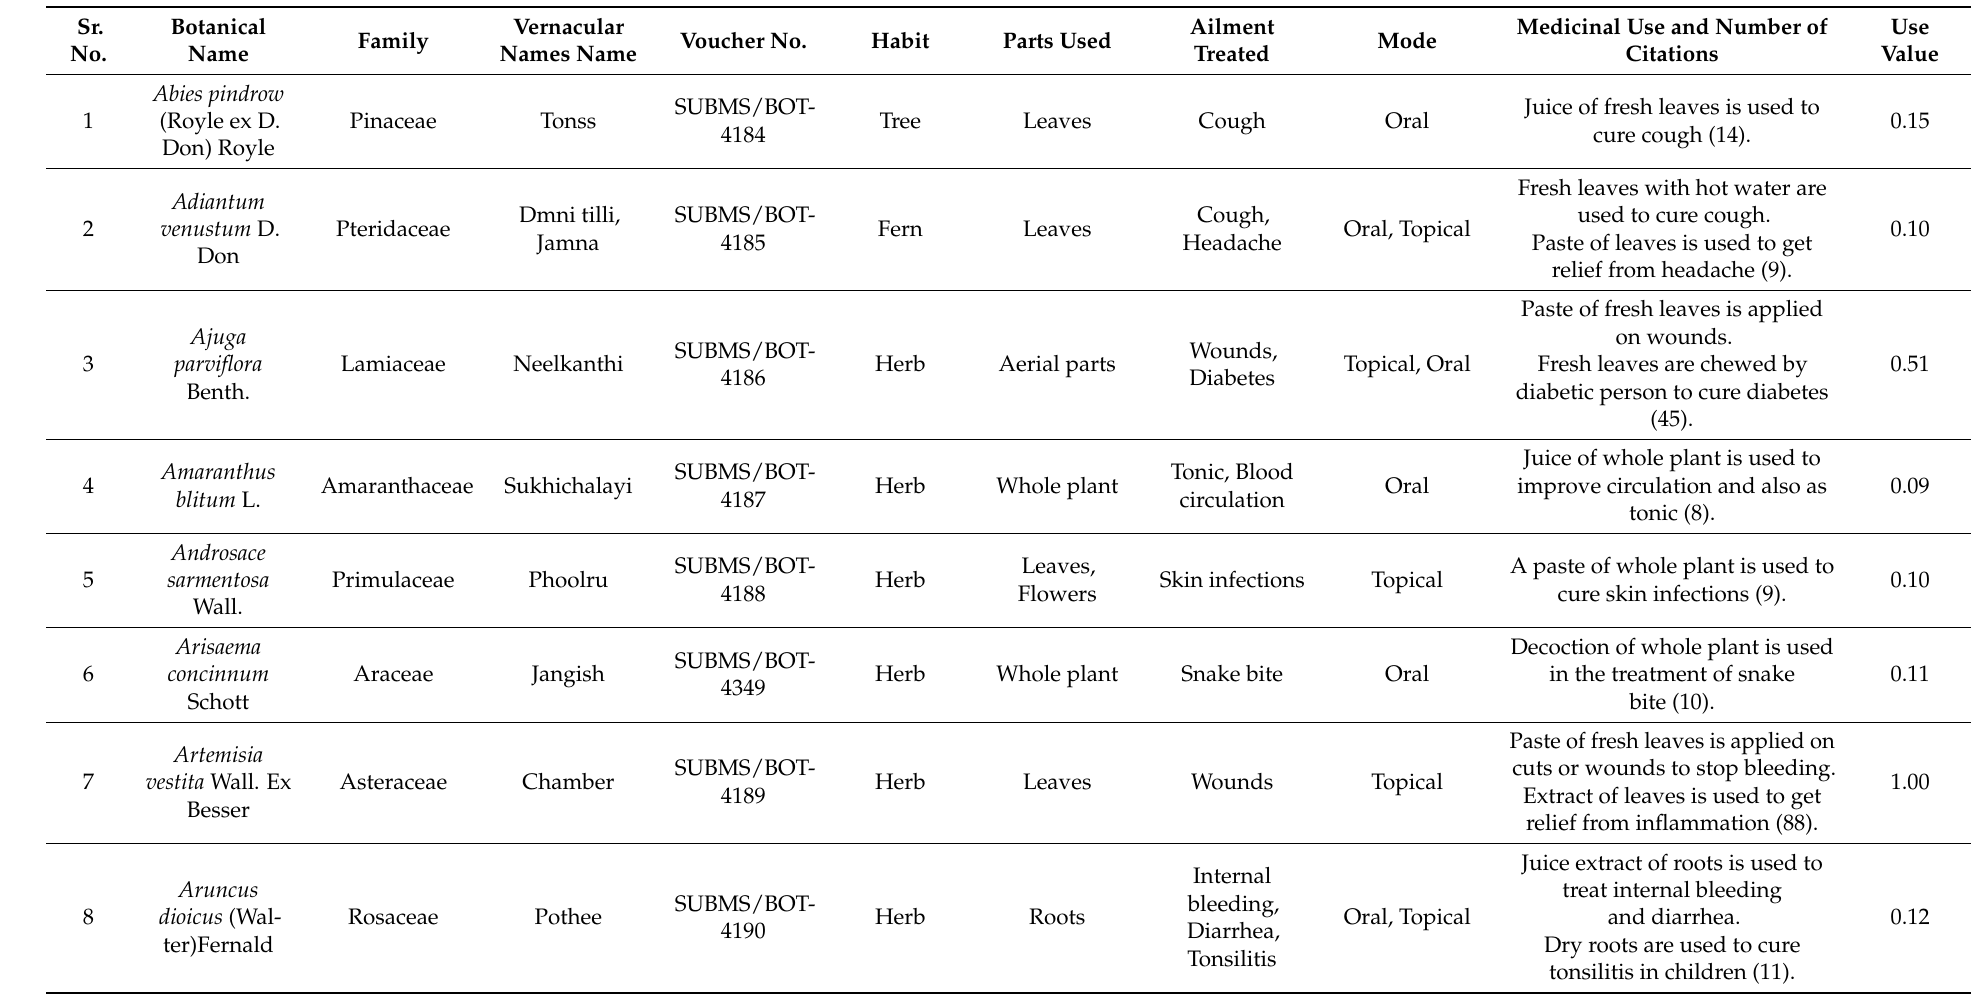
Table 3. Ethnomedicinal plants used in study